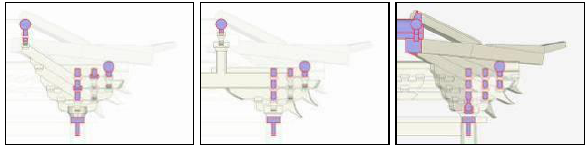
Figure 6 Section of "dou gong" with different kind in a wooden construction.